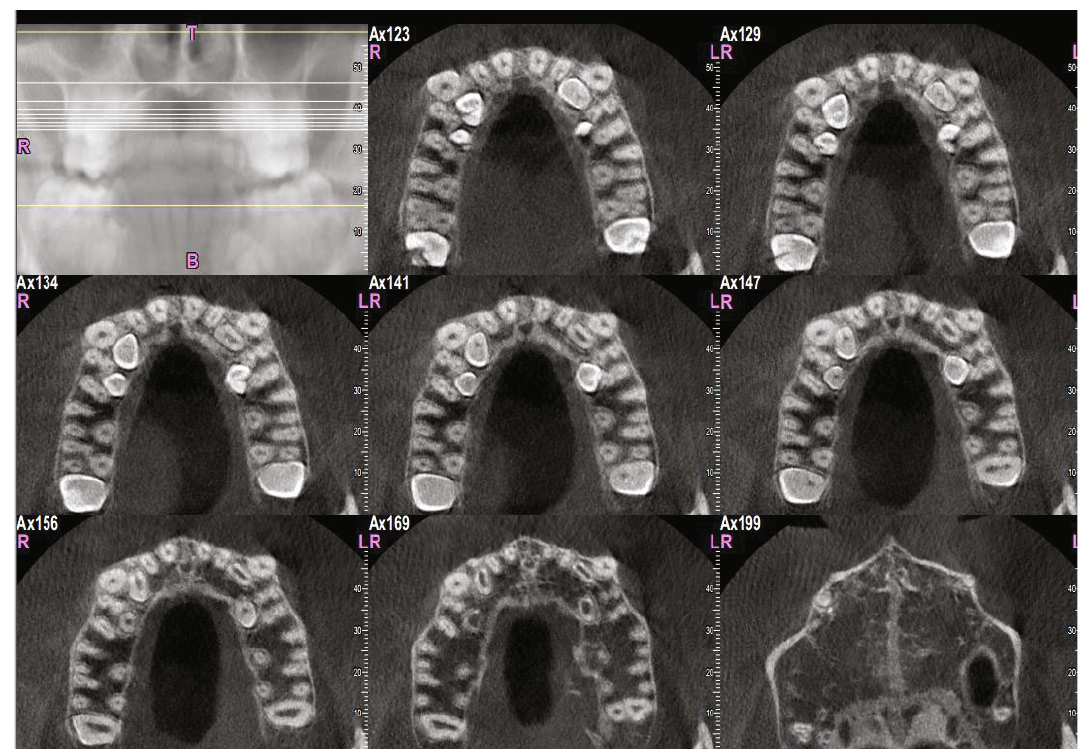
Figure 3: Transverse sections of the maxilla, showing sections of the maxillary supernumerary teeth.